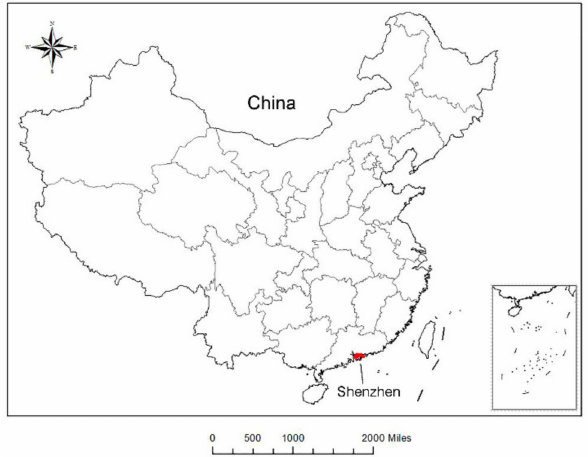
Figure 2. The geographical distribution of Shenzhen in China.